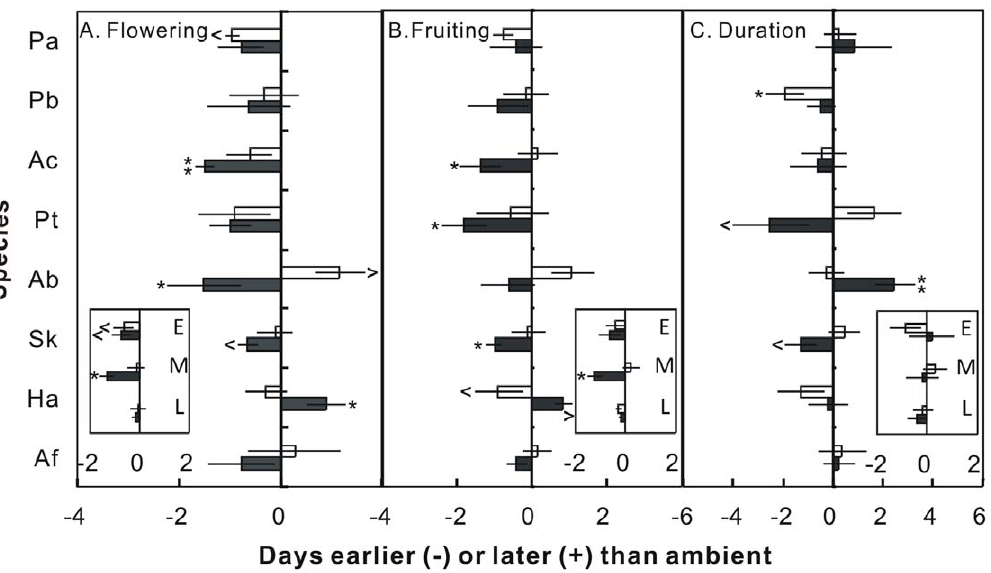
Figure 3. Changes in the flowering time (A), fruiting time (B), and reproductive duration (C) (in days) under day (open bars) and night (filled bars) warming. ‘ , P , 0.10; *, P , 0.05, **, P , 0.05. See Fig. 2 for species name abbreviations.